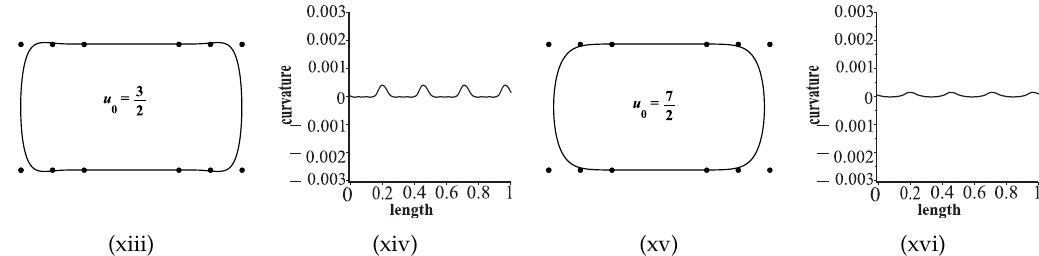
Figure 2. Four subdivision levels of SS (19) and (21) have been used to the control polygon. The results after different values of u 0 are shown on the left together with their corresponding curvature on the right.